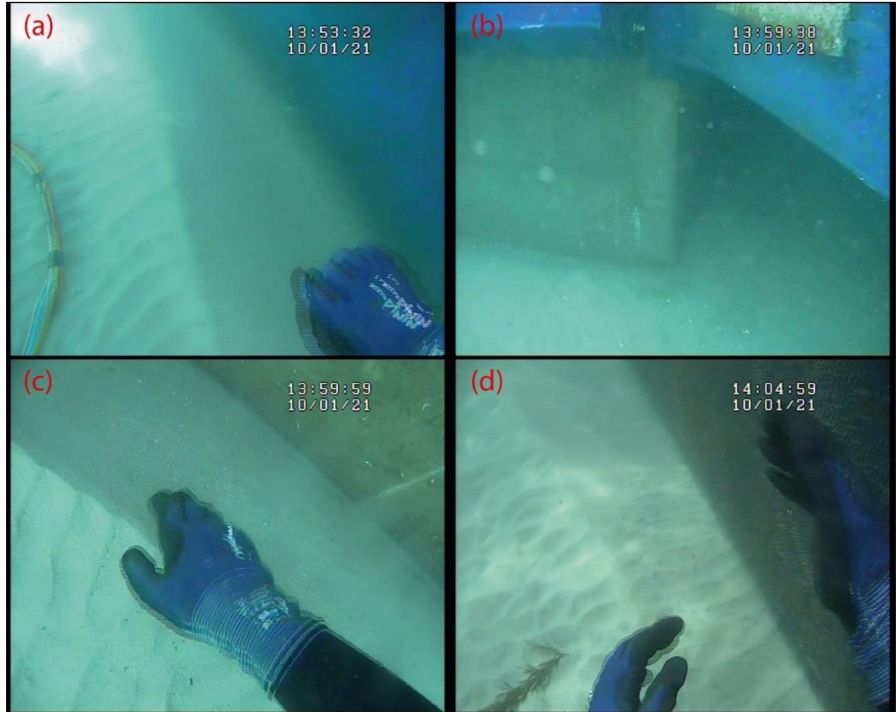
Figure 7. Photographs extracted from dive survey footage around the OWC WEC at Location 1 on 10 January 2021. ( a – d ) refer to photographic references given in Figure 6. ( a ) Scour is seen undermining the Eastern pontoon, with the scour width visibly decreasing in the Northern direction. ( b ) Intersection of the core and pontoon at the South-East corner, no visible scour can be seen underneath the pontoon. ( c ) A scour trench is seen running along the front (Southern) face of the concrete core. ( d ) Scour undermining the Western pontoon.